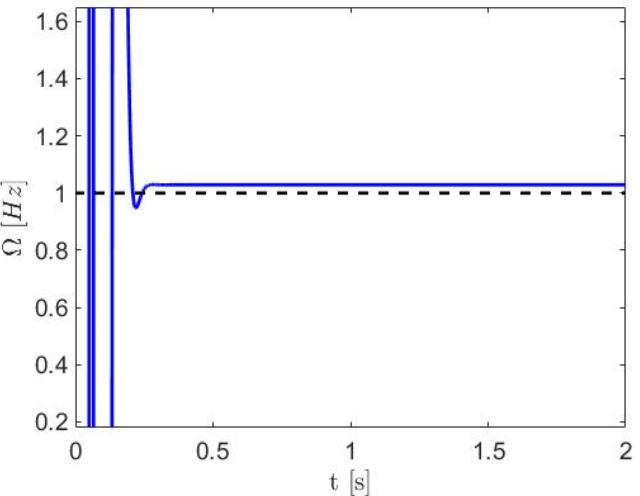
Figure 13. On-line estimation of the frequency of the excitation force using displacement measurements of the third floor or degree of freedom with pendulum absorber